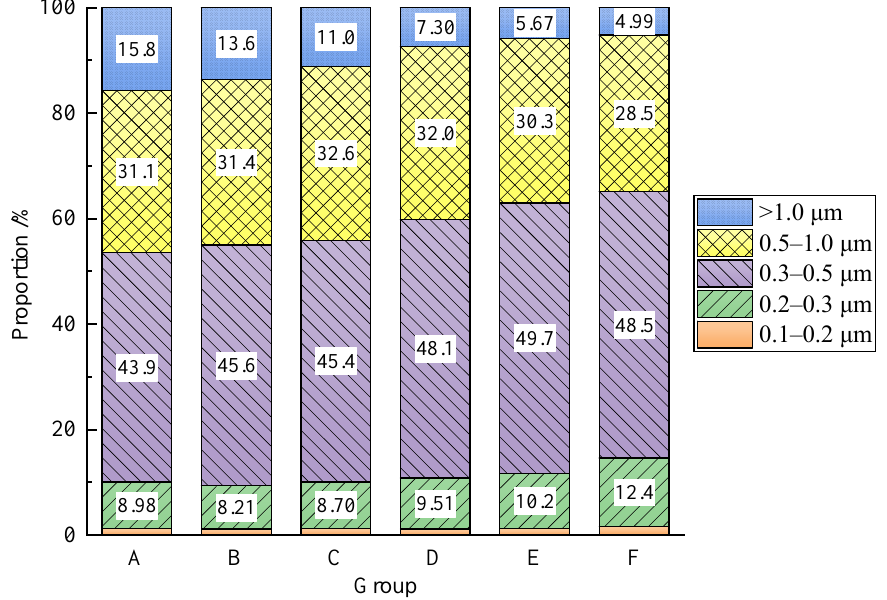
Figure 9. The curve of soil pore diameter under different consolidation times.